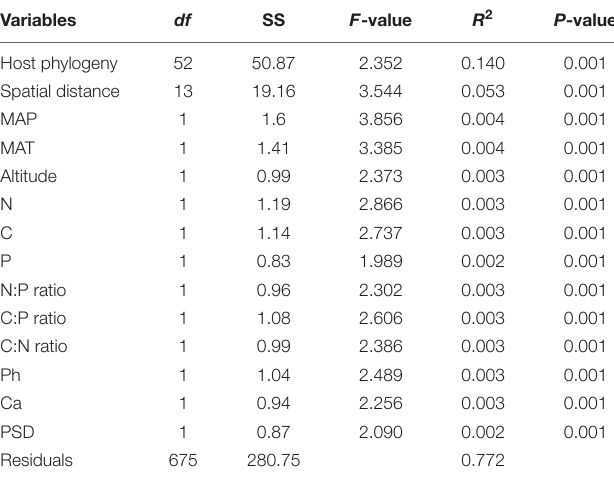
TABLE 2 | Effects of host and abiotic variables on the community composition of ectomycorrhizal fungi as revealed by multivariate permutational analysis of variance.